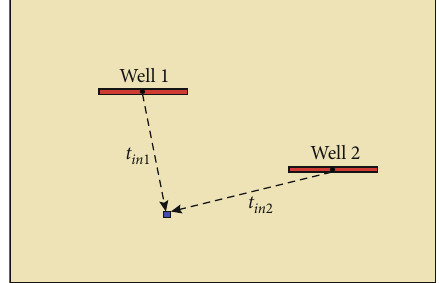
Figure 2: Illustration of the core idea of the proposed